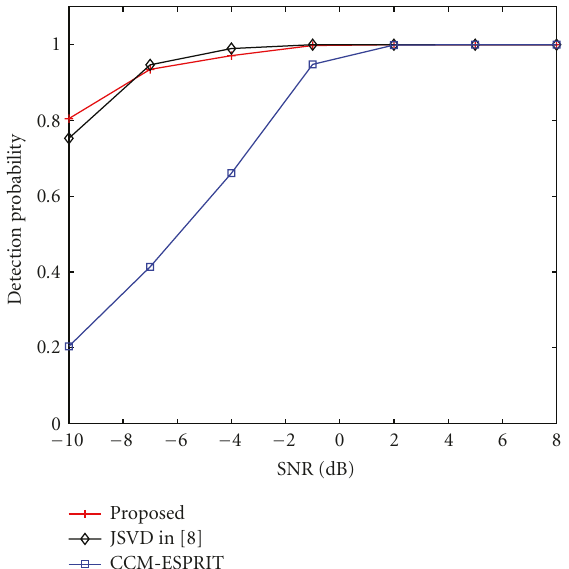
Figure 5: Detection probability verses SNR for two uncorrelated sources with equal power.